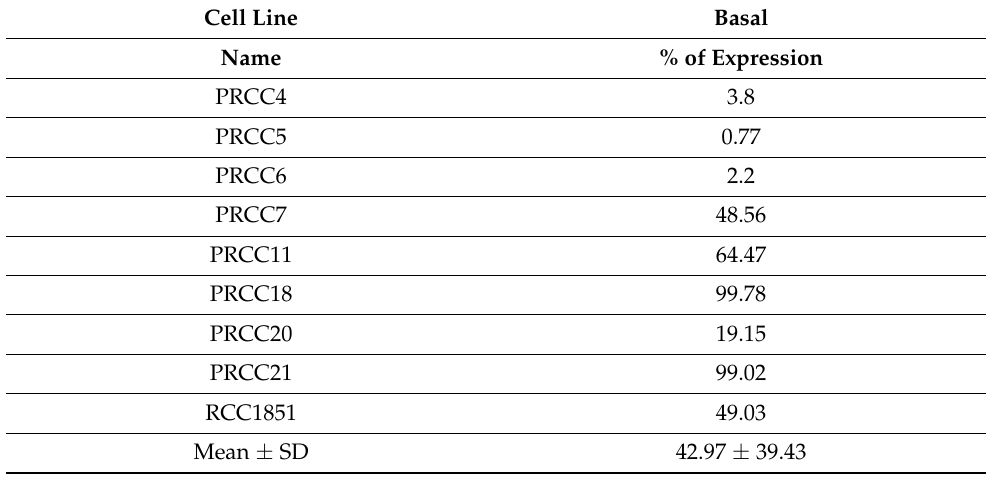
Table 1. Expression on RCC cell lines. RCC cell lines were isolated from kidney tissue samples of patients affected by RCC as described in methods. Data are expressed as percentage of expression.